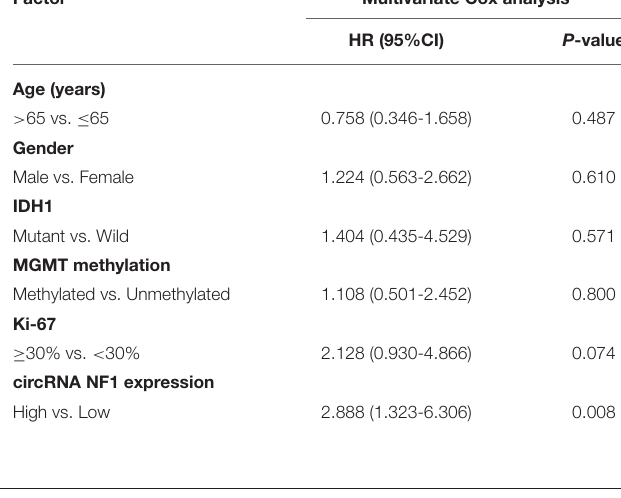
TABLE 1 | The correlations between circRNA NF1 expression and clinicopathological features of GBM patients. Factor circRNA NF1 P -value